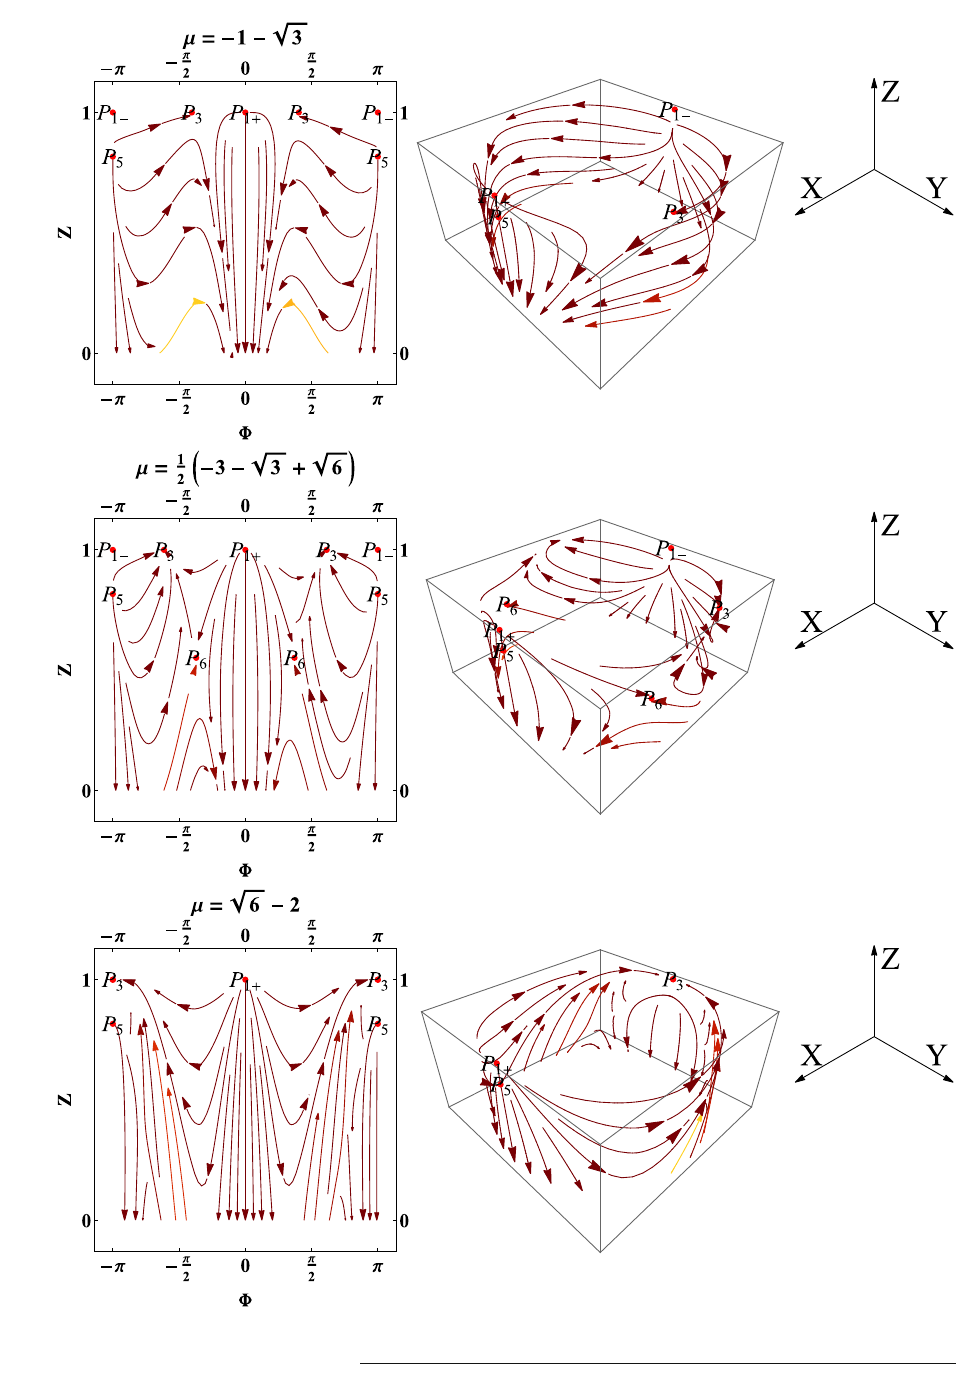
Fig. 1 Unwrapped solution space (left panel) and projection over the cylinder S (right panel) of the solution space of system (69) and (70) for μ = − 1 − √ 3 , 1